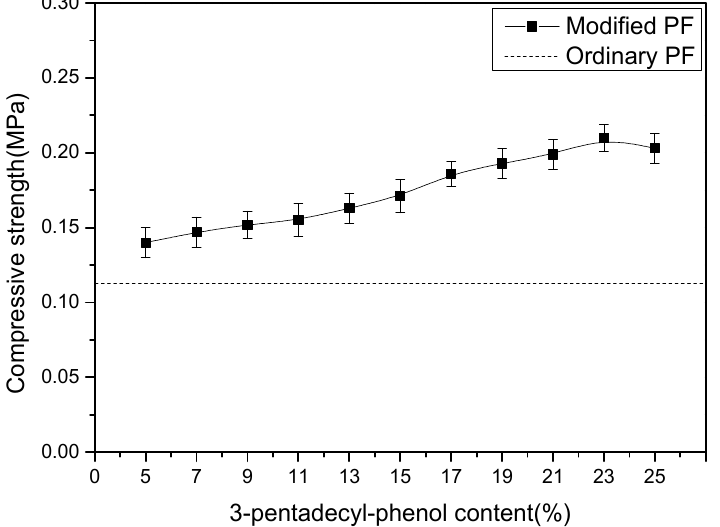
Figure 8. The effect of 3-pentadecyl-phenol with different contents on the compressive strength of the foam.